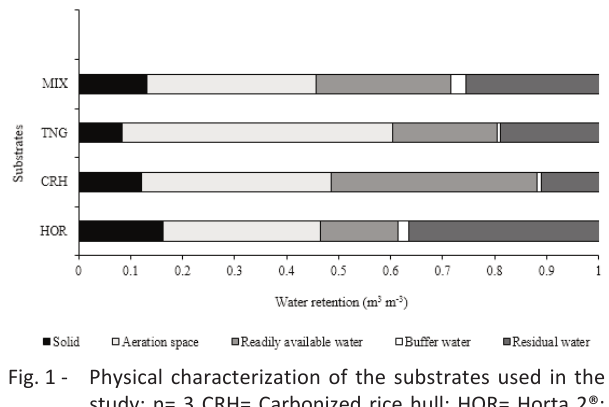
Fig. 1 - Physical characterization of the substrates used in the study; n= 3 CRH= Carbonized rice hull; HOR= Horta 2®; TNG= TN Gold®; MIX= mixture.